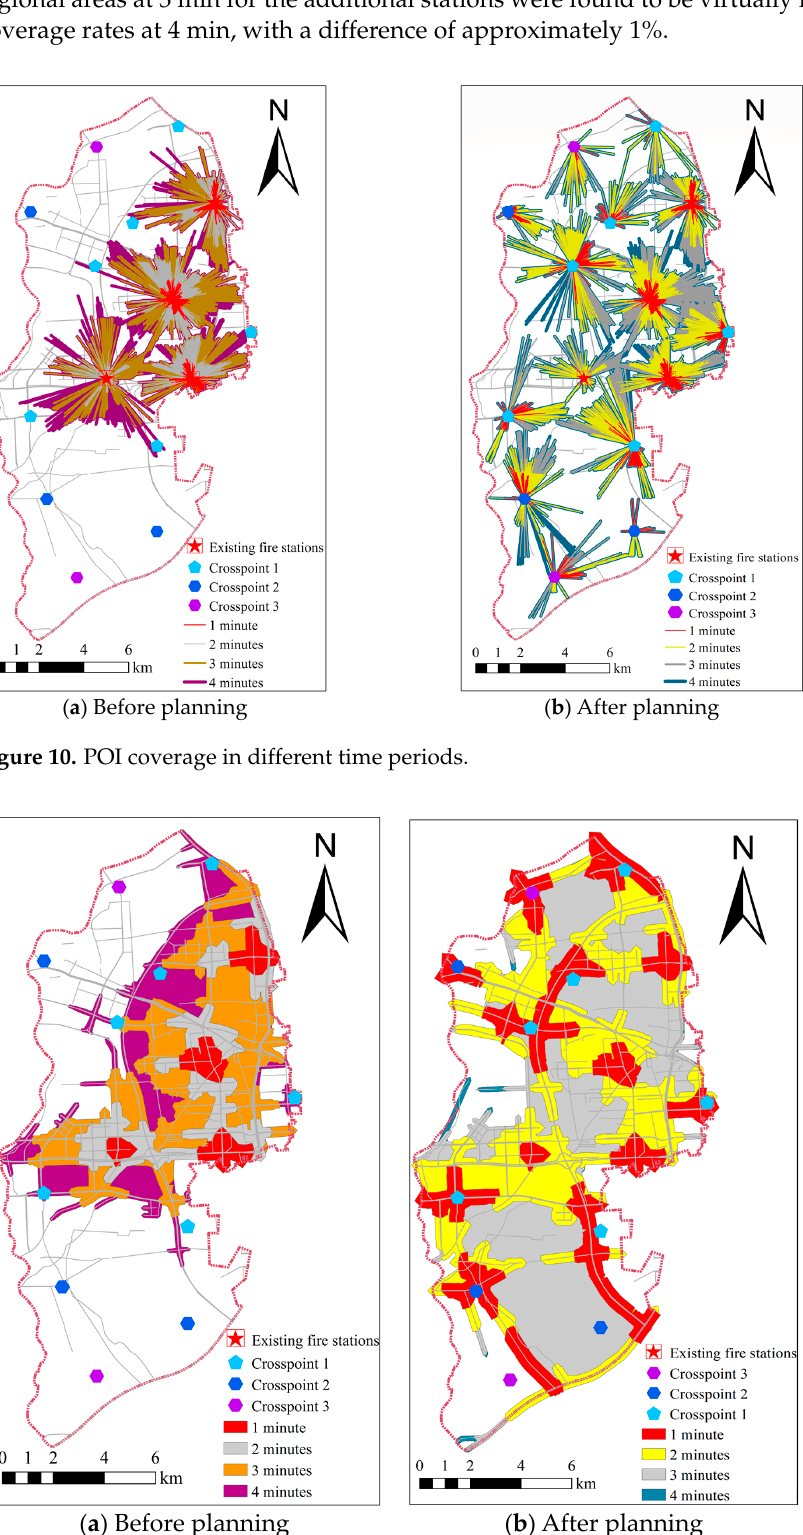
Figure 9. Final fi re station location simulation results.